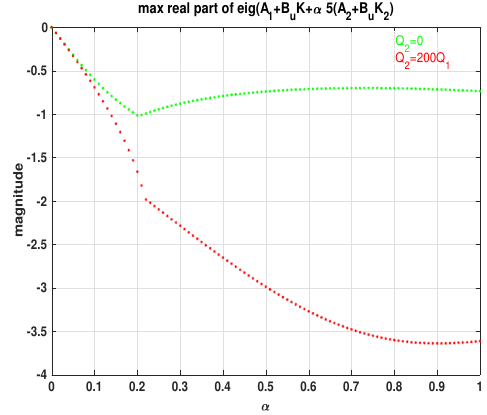
Figure 7. Stability test and validity of Condition